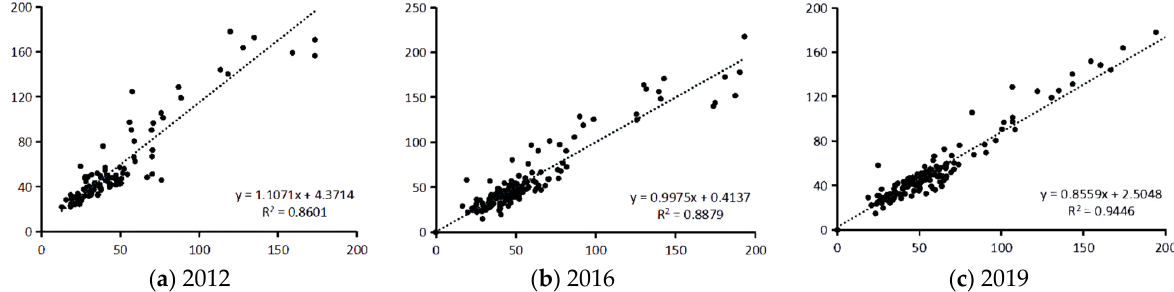
Figure 2. Normalization processing model of the utilized nighttime light data in ( a ) 2012, ( b ) 2016, ( c ) 2019 of study.